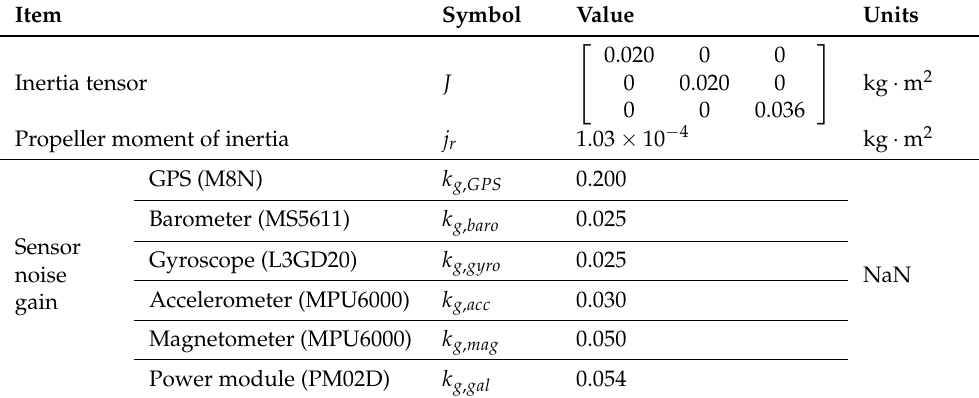
Table 3. Flight control model parameters.